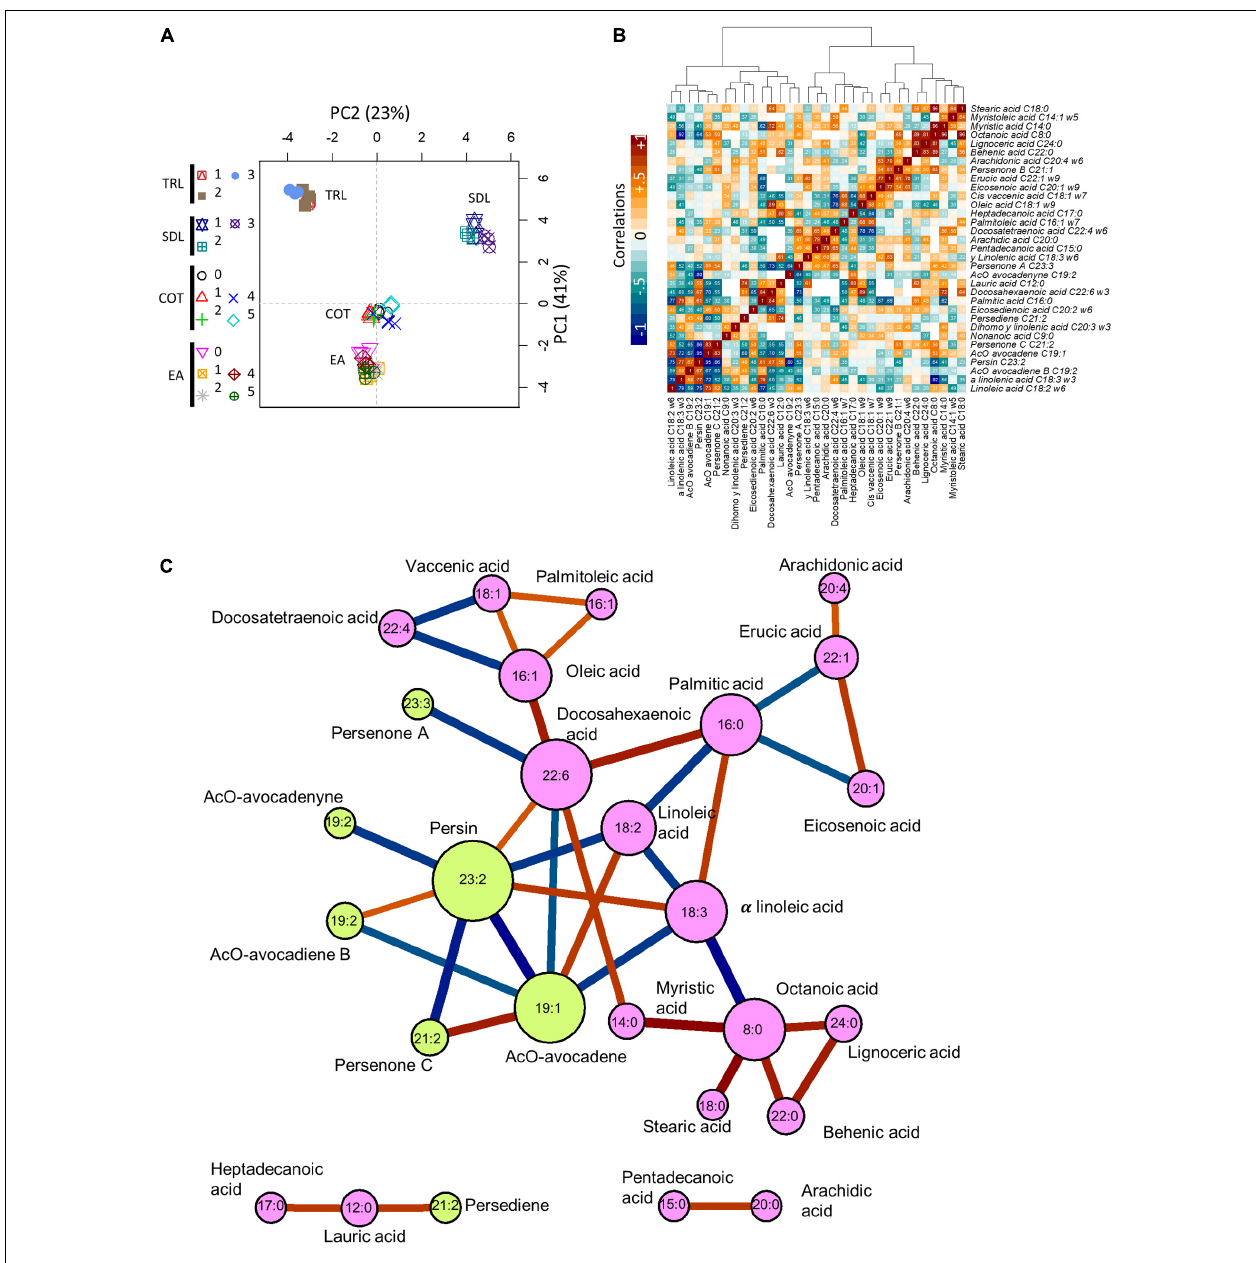
FIGURE 5 | Explained experimental variance and correlation among metabolites. (A) First two principal components associated with main factors, EA, COT, SDL, and TRL in the first component (vertical), and TRL and SDL in the second component (horizontal) after logarithm transformation. (B) Correlation matrix among metabolites clustered by absolute correlation, Euclidean distance, and ward agglomeration. Numbers represent absolute correlation; colors represent correlation value as indicated. (C) The network formed after removing absolute correlations lower than 0.66. Edges color (red, positive; blue, negative) and width represent the correlation. Nodes represent metabolites as labeled; size is proportional to connections. Pink for fatty acids and green for acetogenins. Data were obtained from 56 samples and 112